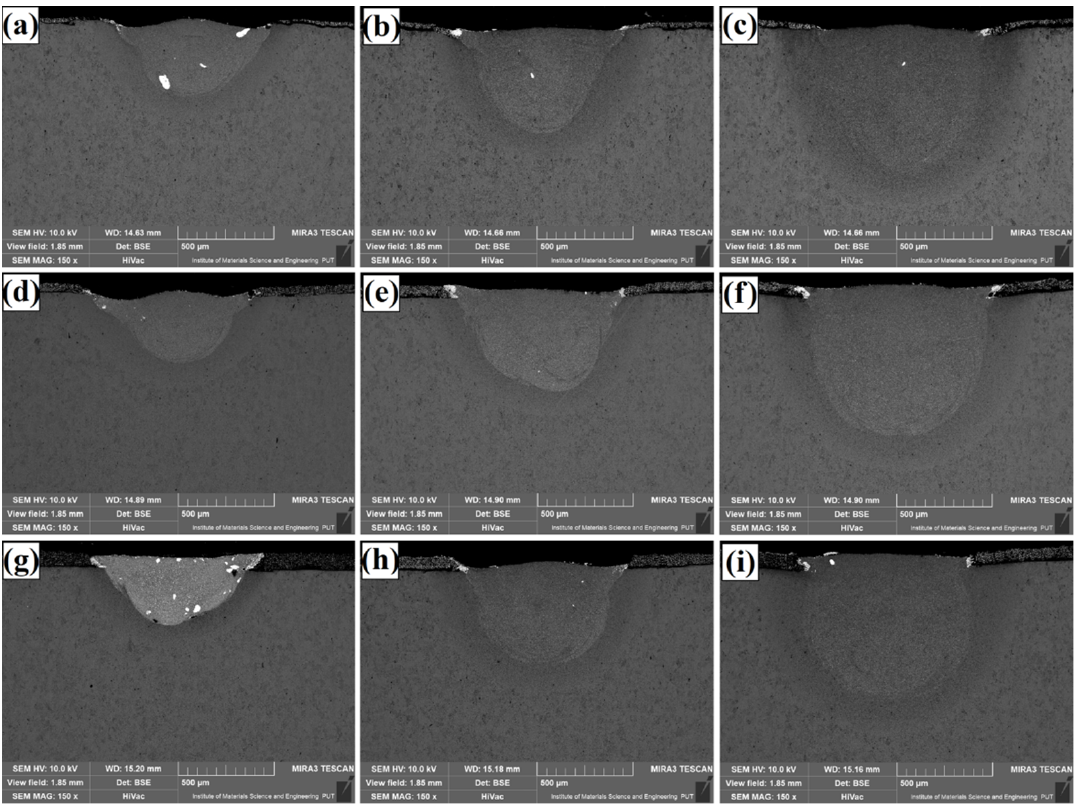
Figure 3. Microstructures of Fe/TaC coatings produced using 500 W, 800 W and 1100 W respectively and pre-coat with thickness of: 30 µm ( a – c ), 60 µm ( d – f ) and 90 µm ( g – i ).